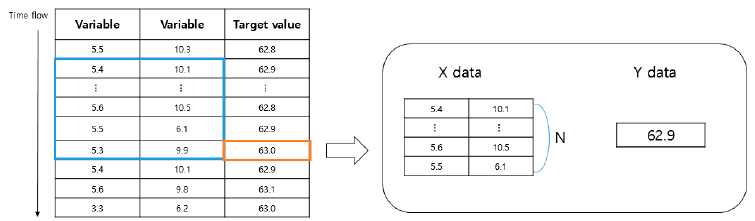
Figure 18. Designation of variables and target data.